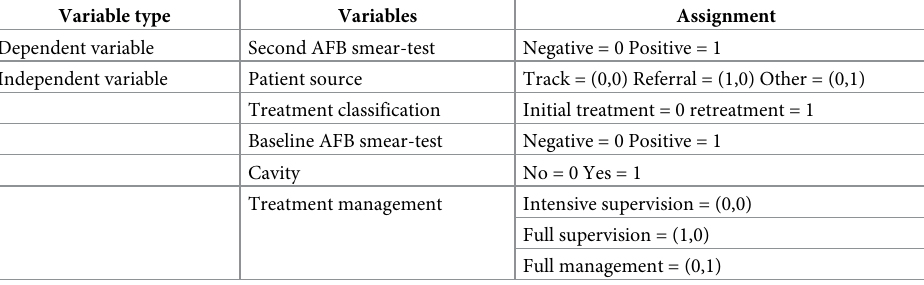
Table 2. Assignment table of dependent variable and independent